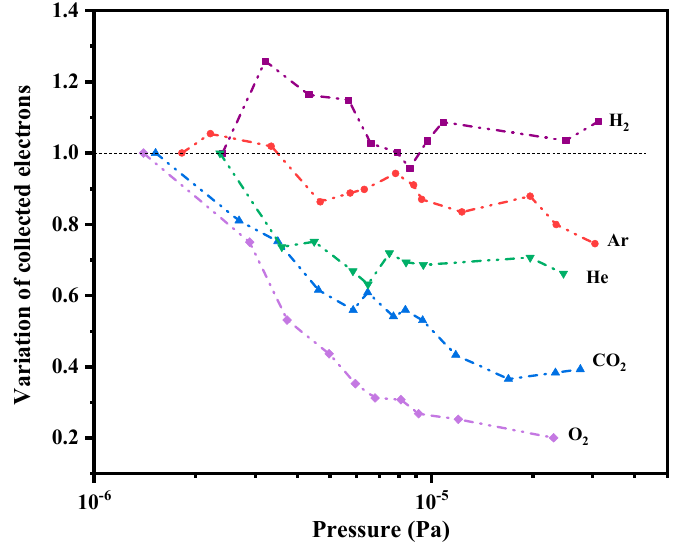
Figure 4. Emission variation caused by gas adsorbates.